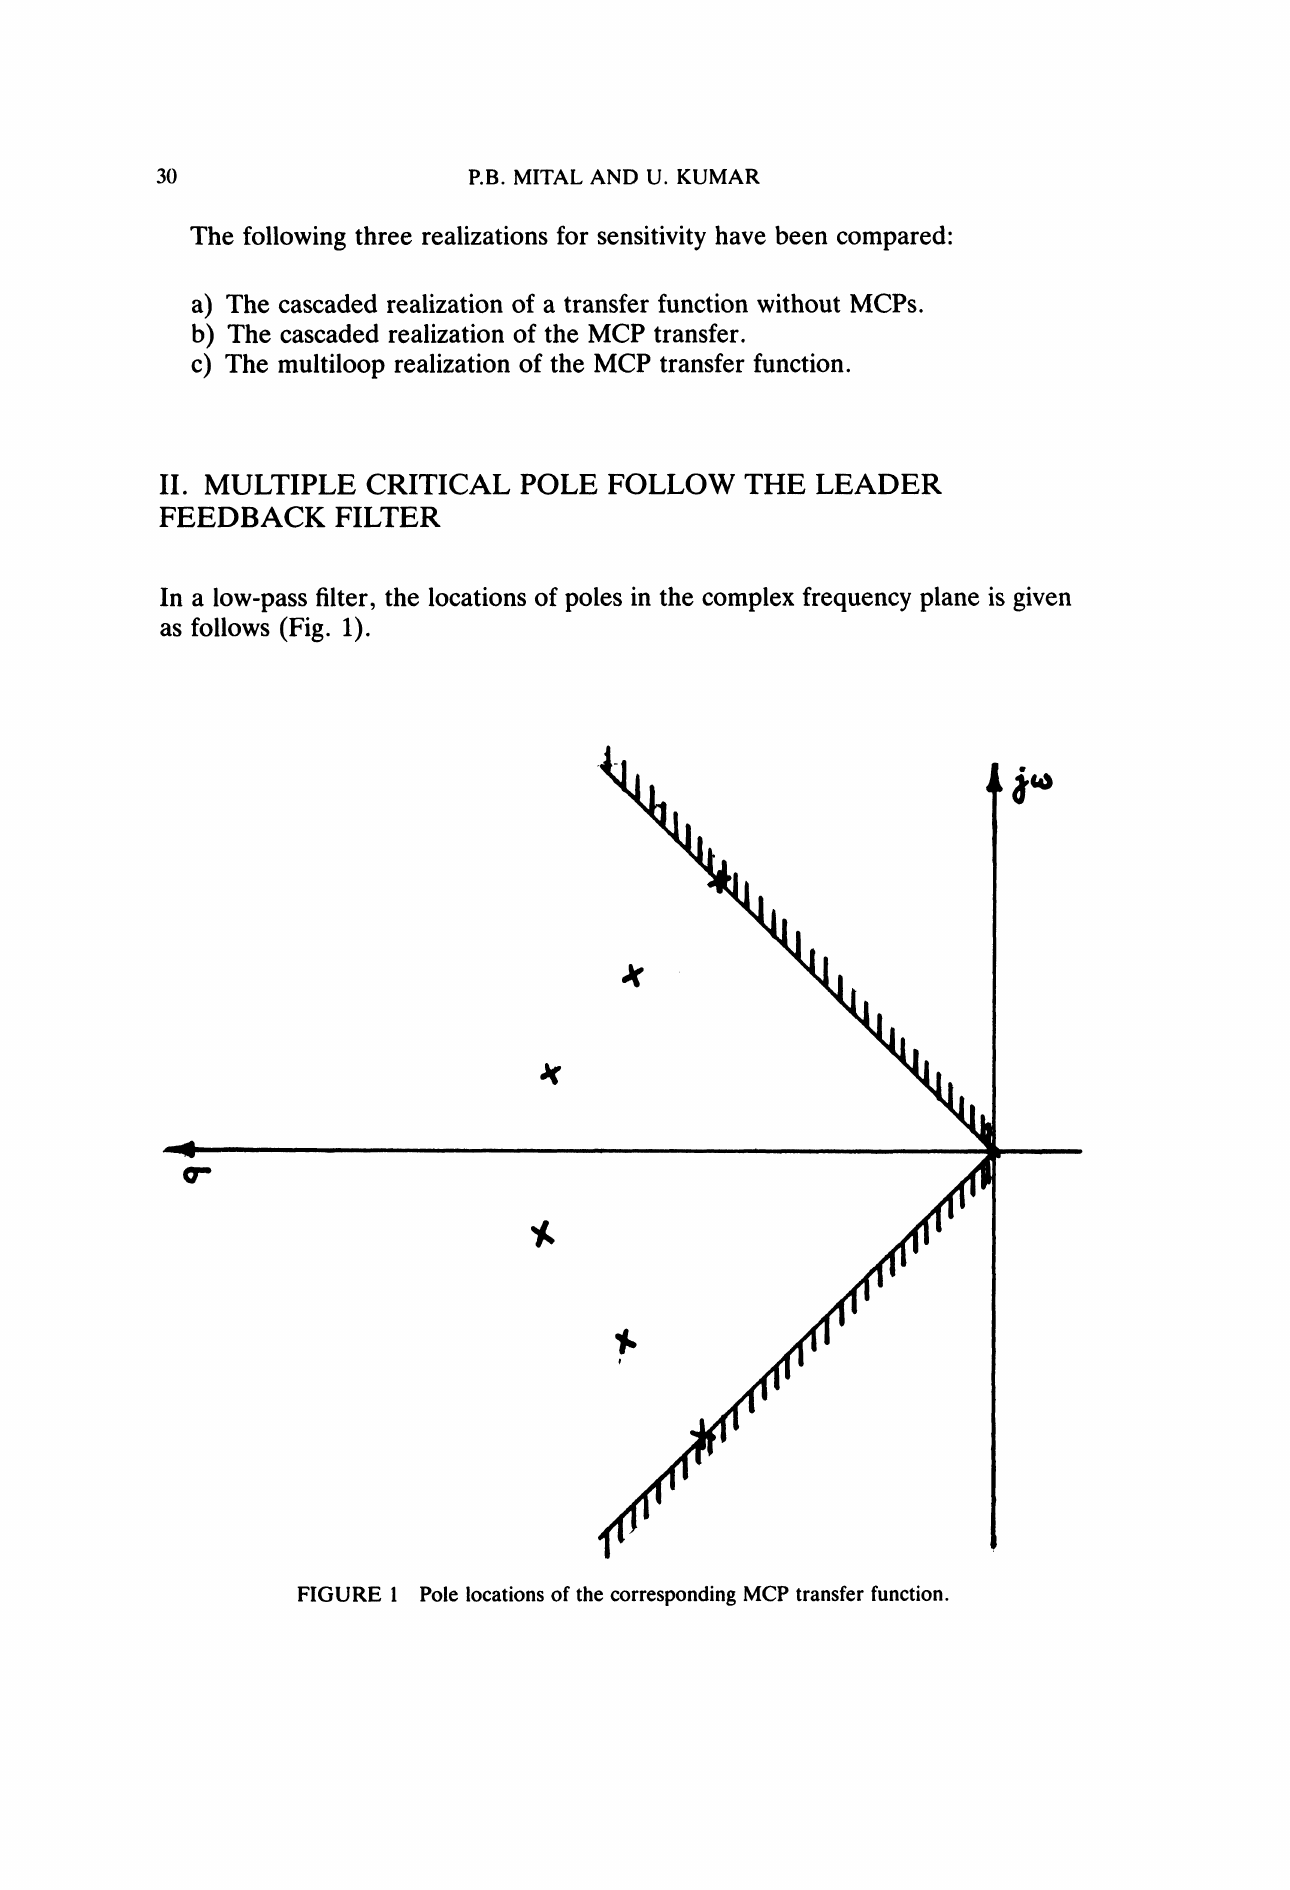
Pole locations of the corresponding MCP transfer